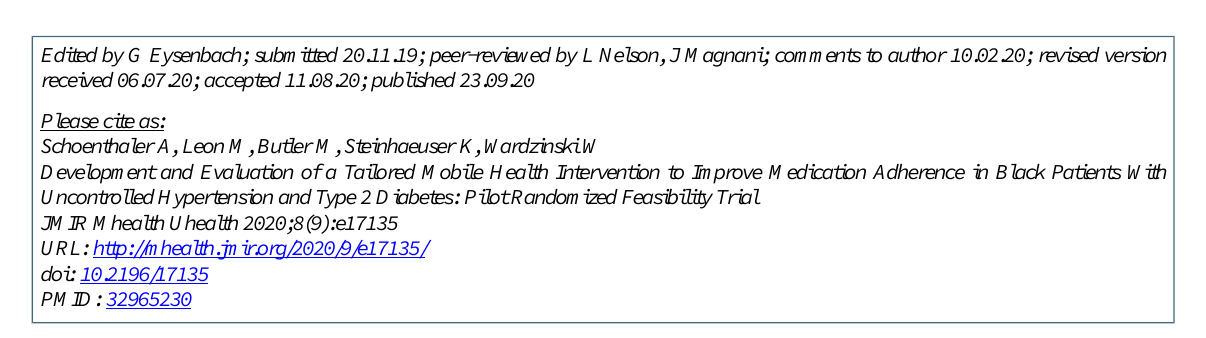
s-TOFHLA: 36-item short-form Test of Functional Health Literacy in Adults SBP: systolic blood pressure T2D: type 2 diabetes